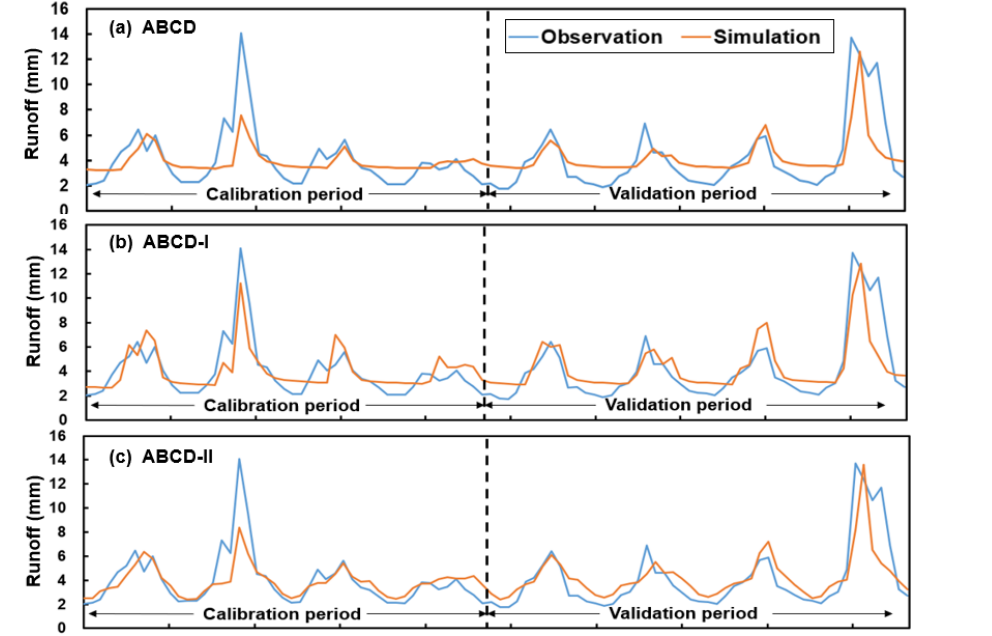
Figure 7. Monthly runoff results of the study catchment in the calibration and validation period obtained from ( a ) the ABCD model, ( b ) the ABCD-I model, and ( c ) the ABCD-II model.